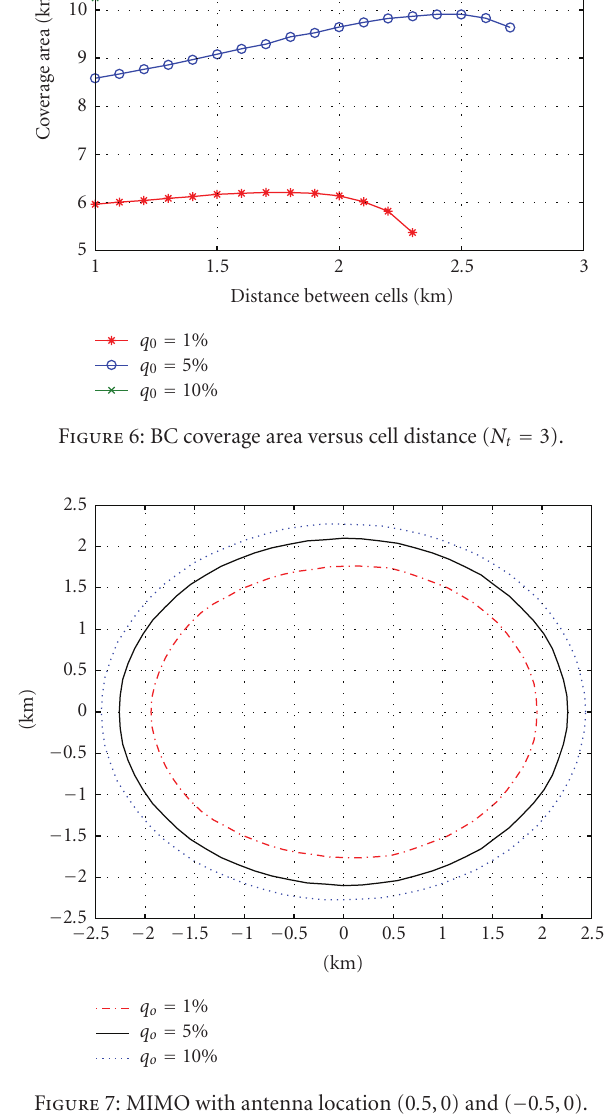
Figure 7: MIMO with antenna location (0 . 5,0) and ( − 0 . 5,0).